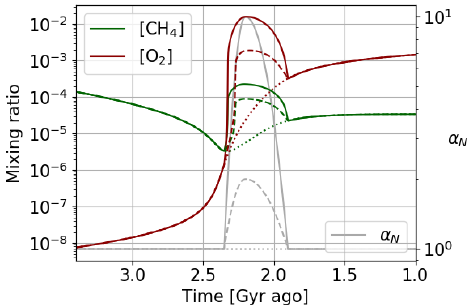
Figure 18. Oxygen and methane temporal evolution. Models with α N constant equalling 1, reaching a factor of 2 and reaching a factor of 10.